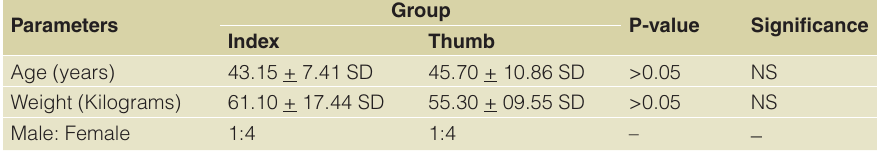
Table 1. Demographic profile of the patients.